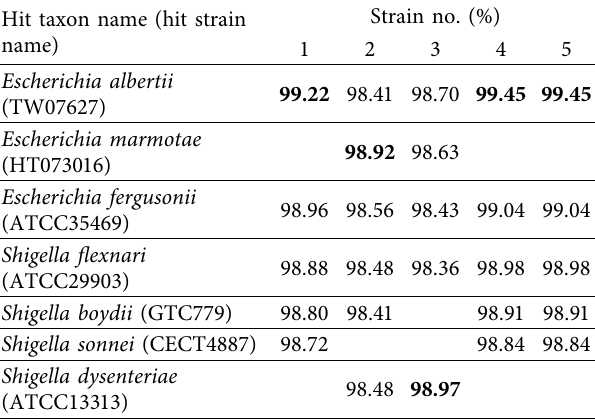
Table 3: 16S rRNA sequence